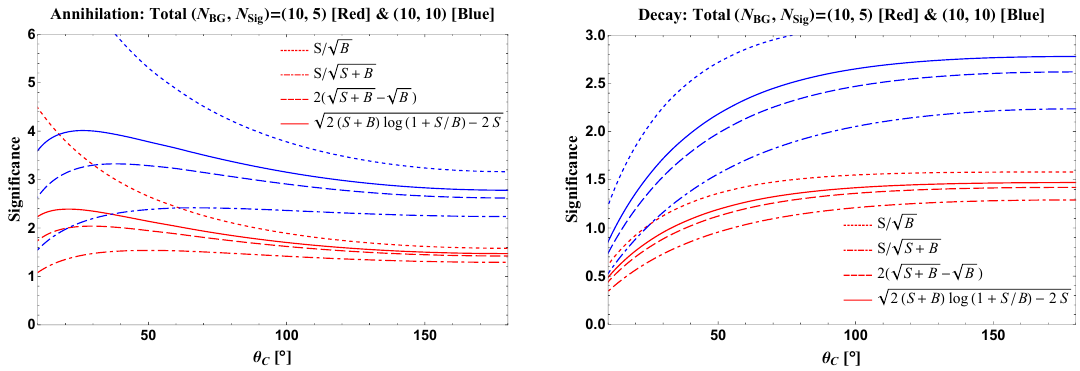
Figure 1 . Signal signi(cid:12)cance as a function of search cone angle (cid:18) C for various calculation methods. Signals originate from DM annihilation (left panel) and DM decay (right panel). The total expected numbers of background and signal events from all sky are normalized to ( N BG ; N Sig ) = (10, 5) and (10, 10) for red and blue curves,